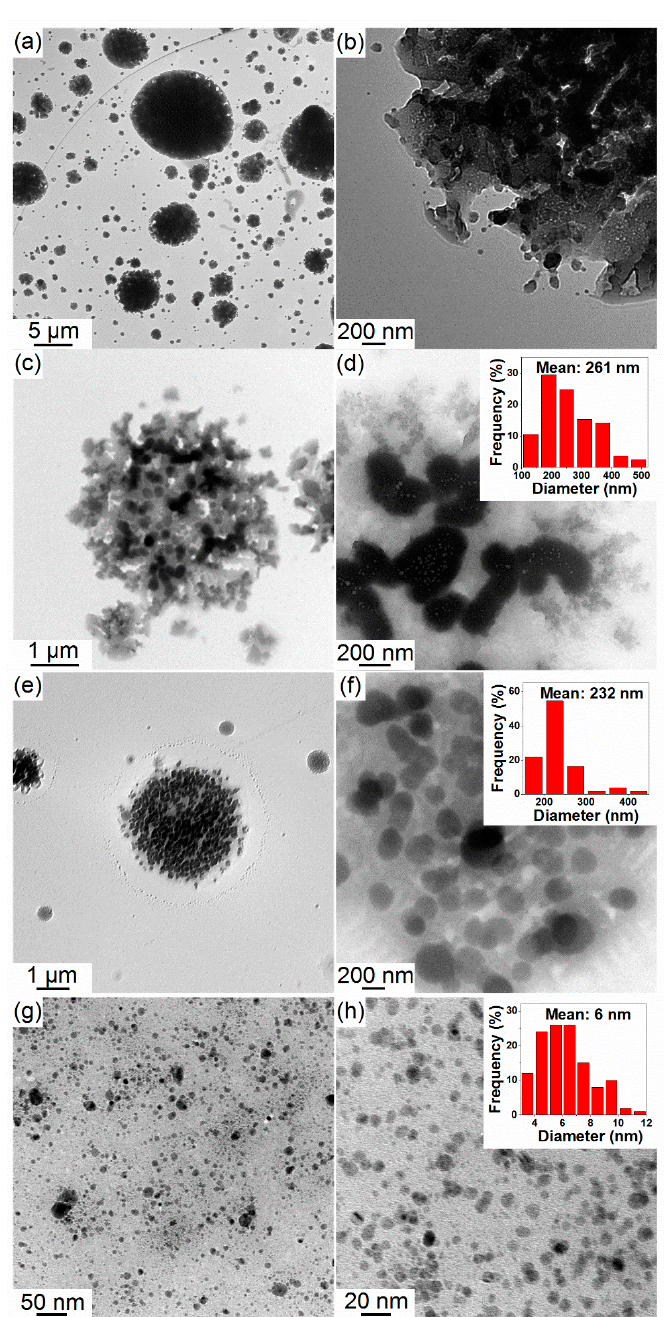
Figure 1. Transmission Electron Microscopy (TEM) images of ( a , b ) NaBH 4 -SG1.2; ( c , d ) NaBH 4 -SG1.8; ( e , f ) NaBH 4 -SG2.4; and ( g , h ) NaBH 4 -SG5.9. The inset diagrams are the corresponding mean particle sizes and size distribution.